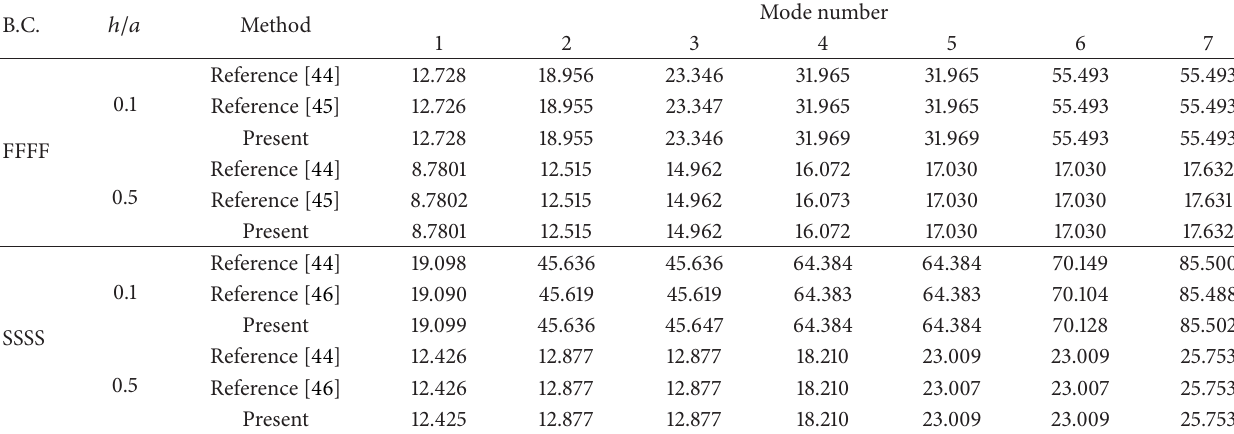
Table 2: Comparison of frequency parameters Ω = 𝜔𝑎 2 √𝜌ℎ/𝐷 of isotropic square plates with FFFF and SSSS boundary conditions ( 𝐸 = 210 GPa, 𝜇 = 0.3 ).